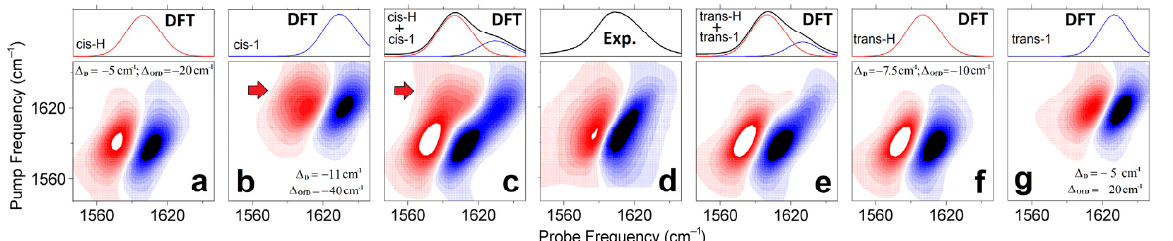
Figure 5. 2DIR and linear spectra computed for cis -H ( a ), cis -1 ( b ), trans -H ( f ), trans -1 ( g ) model systems. The line-shapes are according to the frequency fluctuation correlation function, the diagonal anharmonic shifts, and the off-diagonal anharmonic shifts calculated as described in the Materials and Methods. ( c , e ) sums of the 2DIR contributions computed for the cis -H and cis -1 cases and for the trans -H and trans -1 cases in the ratio 3:1. ( d ) 2DIR experimental spectrum of a Cu(L-proline) 2 complex at 0.9 ps time-delay and FITR spectrum. and calculated 2DIR responses for the selected model systems. Red arrows in panels ( b , c ) indicate cross-peaks due to off-diagonal anharmonicity as anticipated for carbonyls in the cis -1 structure. Computed linear spectra (red and blue lines) are slightly asymmetric: each line-shape includes both a dominant-intense antisymmetric stretching resonance, and a weak symmetric stretching resonance contributing into a slight broadening at the higher frequency